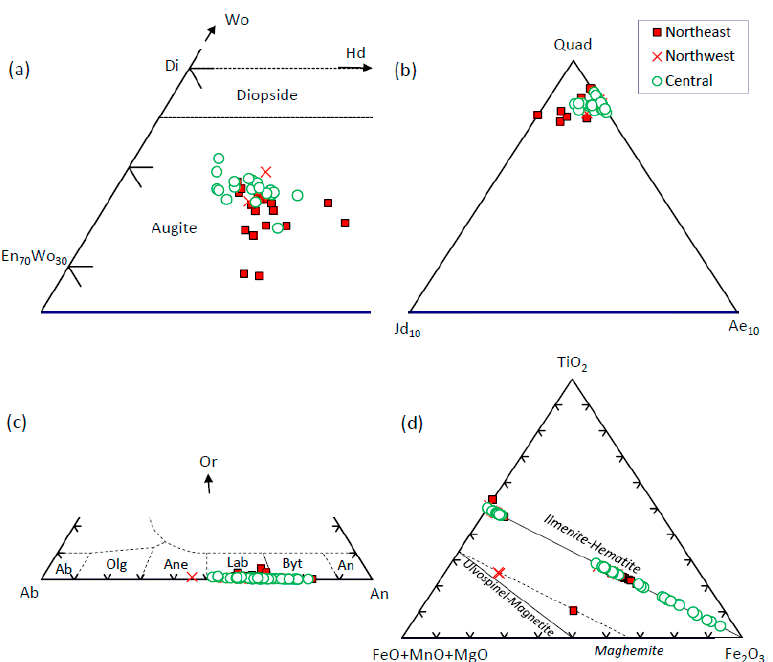
Figure 5. Chemical composition of minerals in the Rajmahal basalts from the northeast, northwest, and central sectors (see Figures S1–S3 for further details). ( a , b ) Average augite (En—enstatite, Di— diopside, Hd—hedenbergite, Wo—wollastonite, Quad—quadrilateral components, Jd—jadeite, and Ae—aegirine) plotted according to [53]. ( c ) Plagioclase (Ab—albite, Olg—oligoclase, Ane—an-